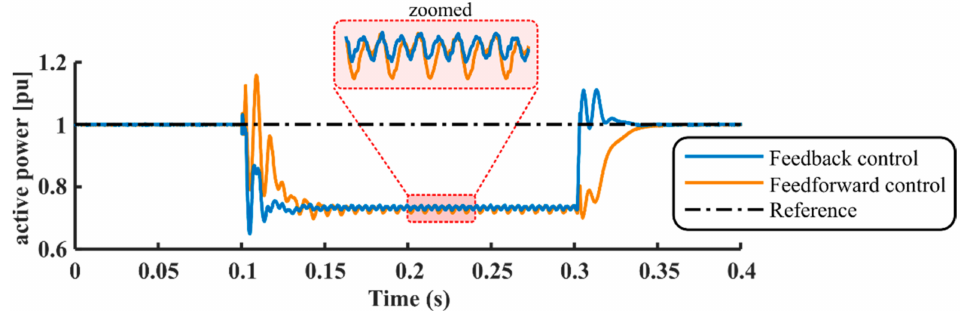
Figure 16. Performance comparison of active power with feedback and feedforward control methods under the SLG fault.